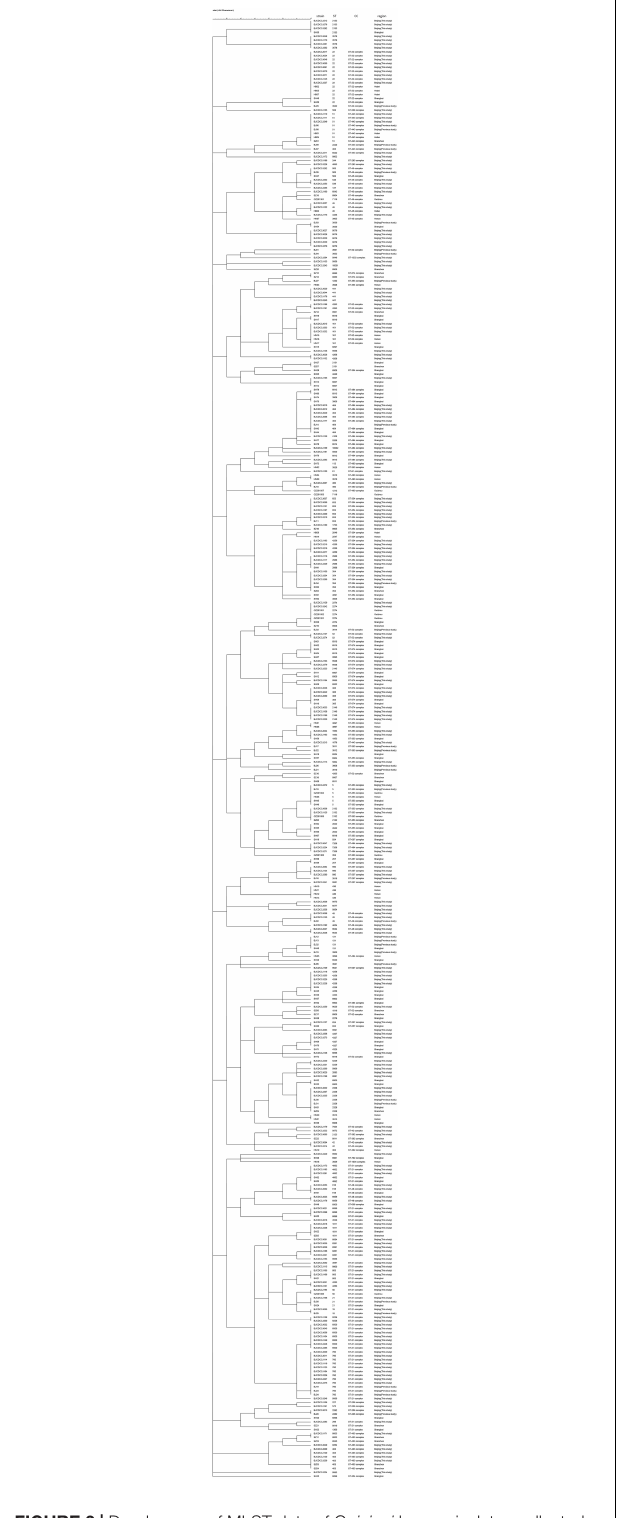
Frontiers in Microbiology |